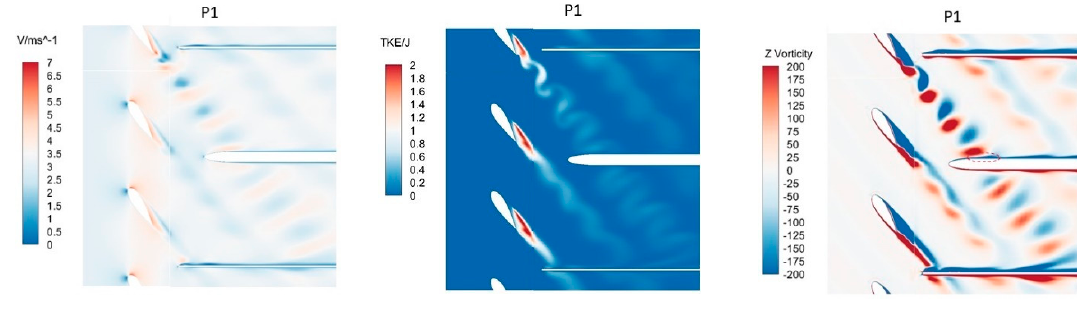
( a ) Contours at phase 1, left: velocity, middle: turbulence kinetic energy, right: z vorticity.